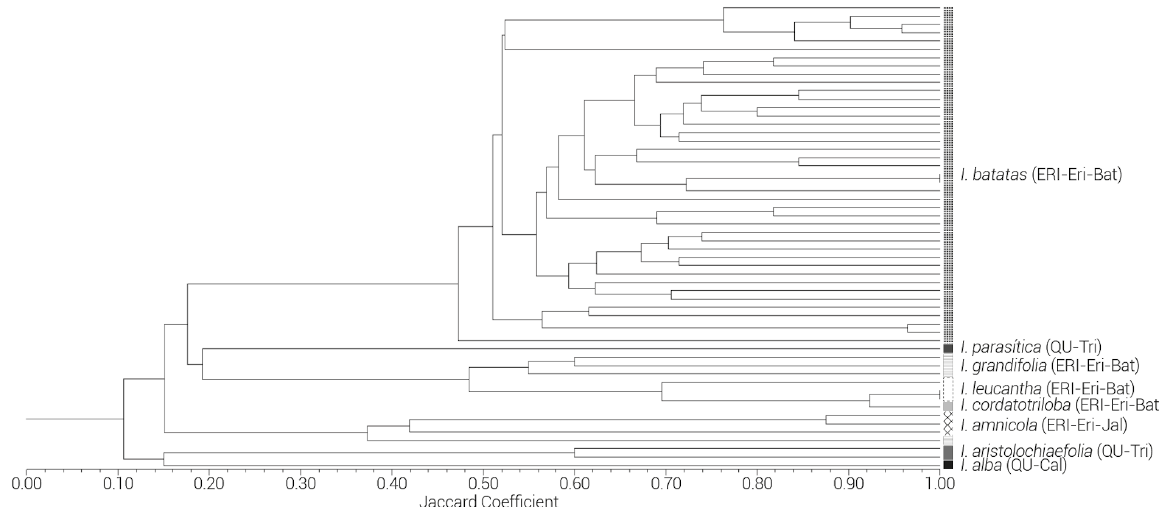
Figure 5. Dendrogram of 41 accessions of sweet potato and 15 wild Ipomoea species. Species are followed by abbreviations referring to the classification of Austin and coworkers. Subgenera: ERI= Eriospermum , QU= Quamoclit ; Sections: Tri= Tricolores , Cal= Calonyction , Eri= Eriospermum ; Series: Jal= Jalapae , Bat= Batatas